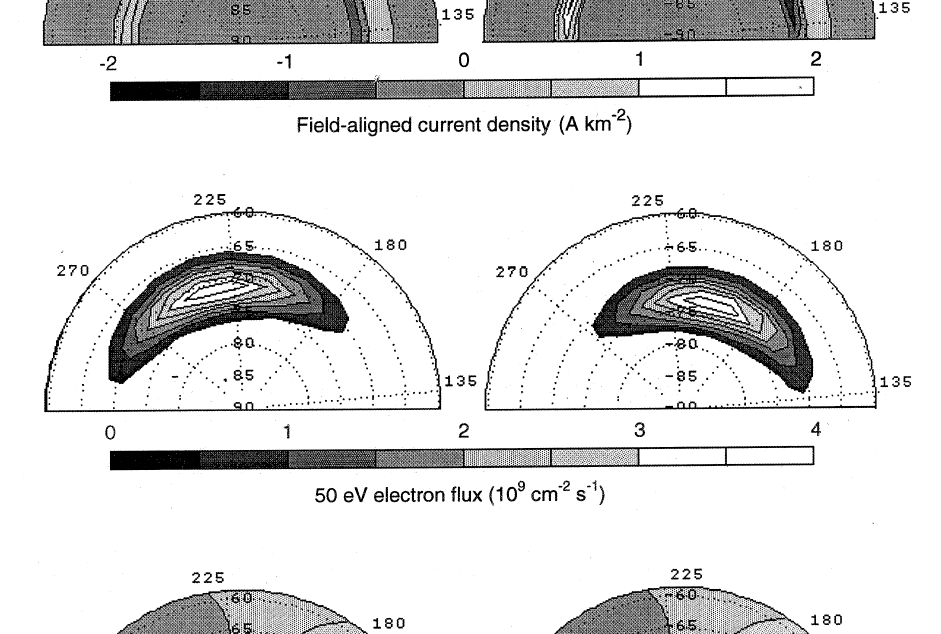
Fig. 4. Approximations of the field-aligned current density and soft electron (a Maxwellian with characteristic energy of 50 eV) precip- itating flux data ( two upper panels ) used as inputs for the second variant of the model calculations. Bottom panel shows the calculated